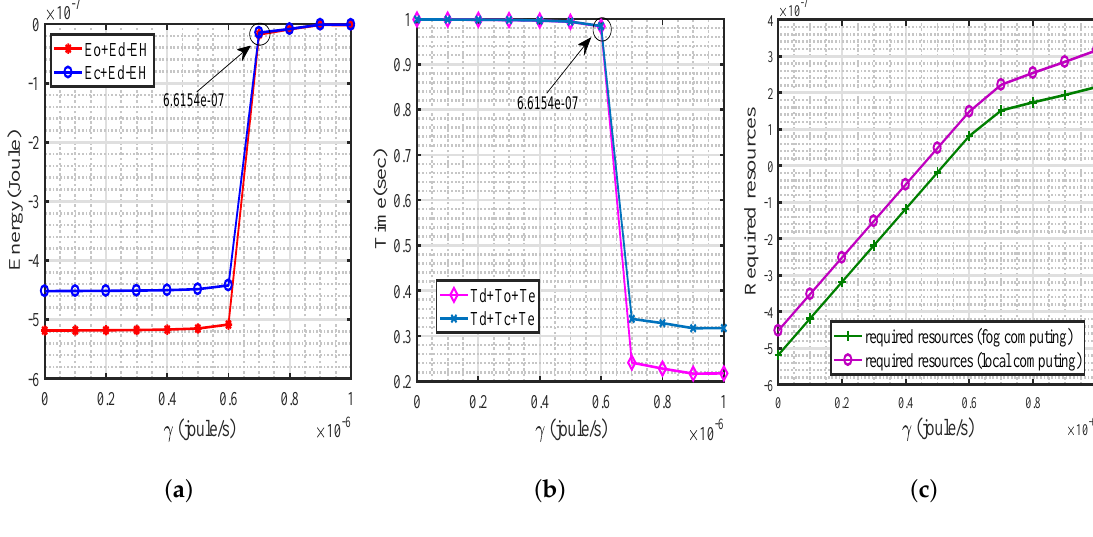
Figure 8. System performance versus γ